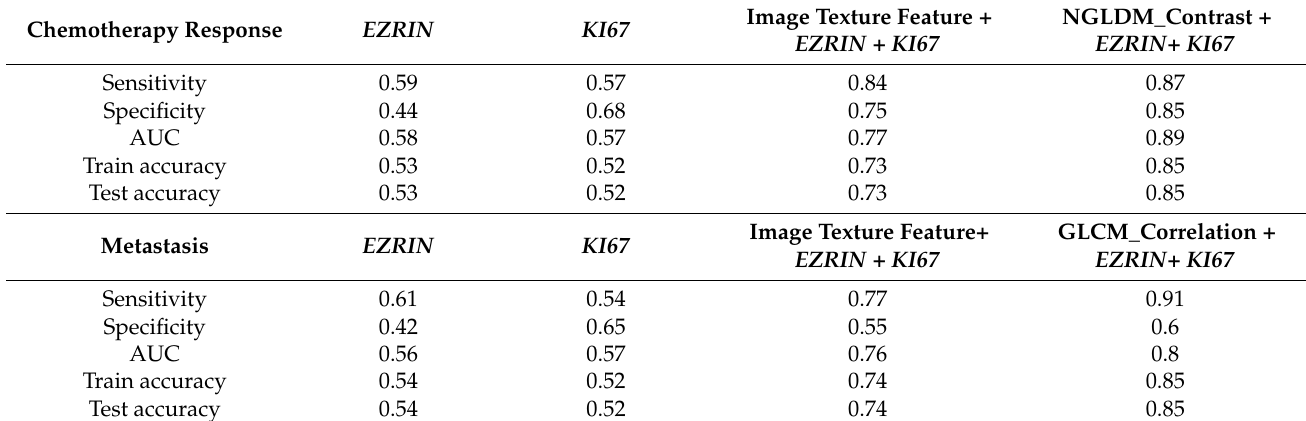
Table 3. Chemotherapy Response and metastasis prediction model with gene expressions, combination of gene expression image texture features and gene expression and combination of area under curve max (AUC_max) image texture and gene expressions.